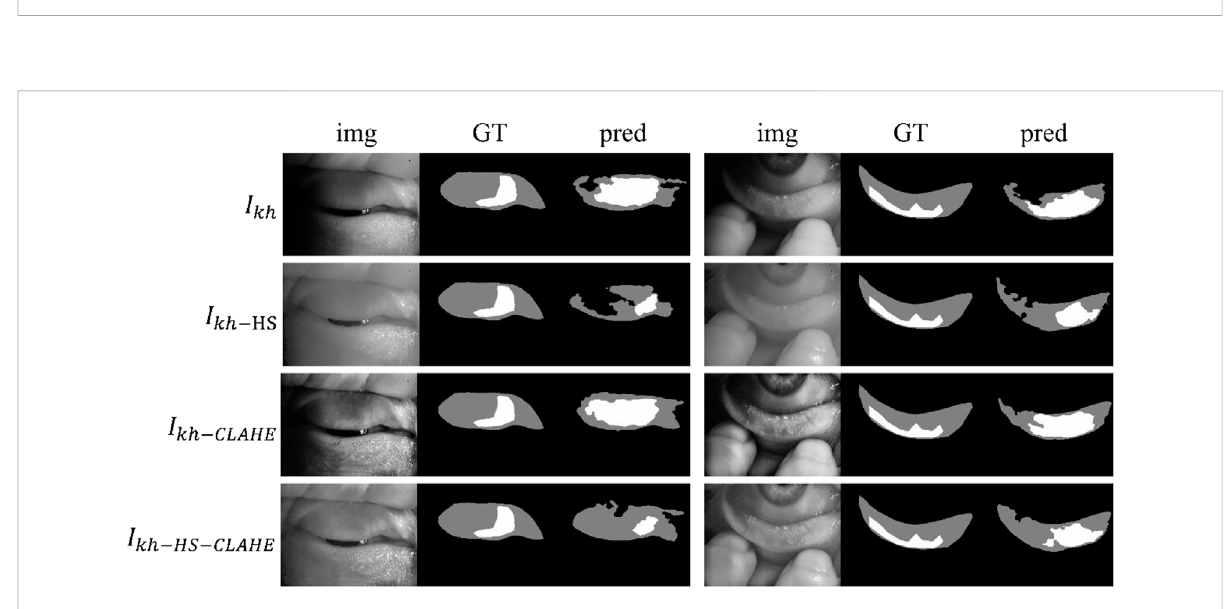
FIGURE 5 Some under-segmented examples in the external testing set due to the distribution gap. Img, GT, and pred represent input images, ground- truth masks, and predicted segmentation masks,